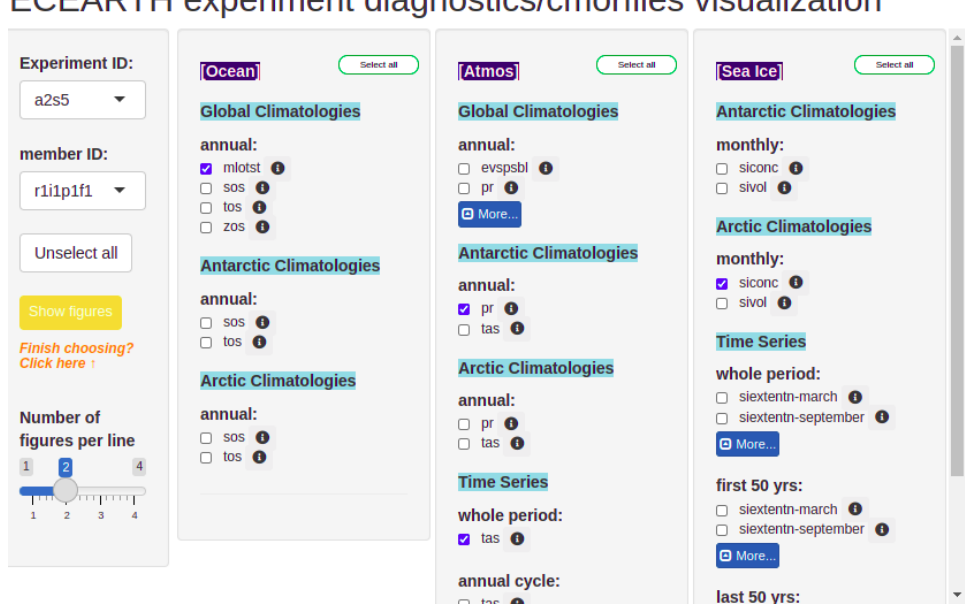
Figure B1. Screenshot of the R Shiny app that has been developed to conveniently and interactively visualize the results of EC-Earth3 simulation